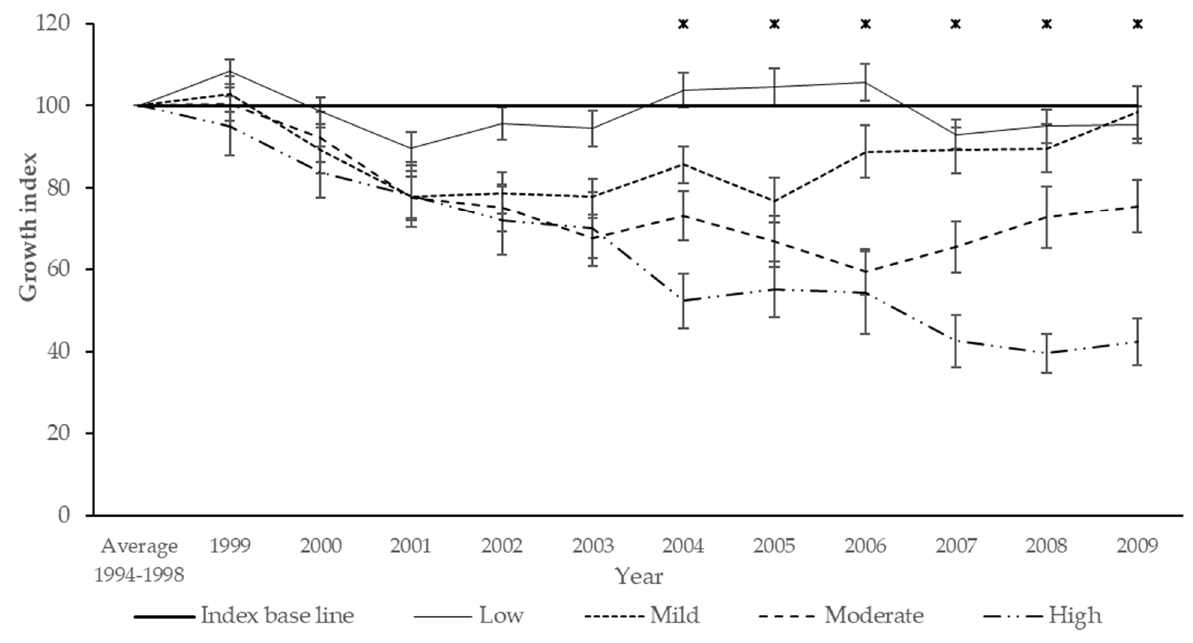
Figure 2. Growth indices from five pre-outbreak years. The base line (index value 100, thin black line) represents five-year (1994–1998) mean growth before the outbreak. At least two growth indices of defoliation classes were statistically significantly different (* p < 0.05) for every year from 2004 according to the Kruskall–Wallis test.